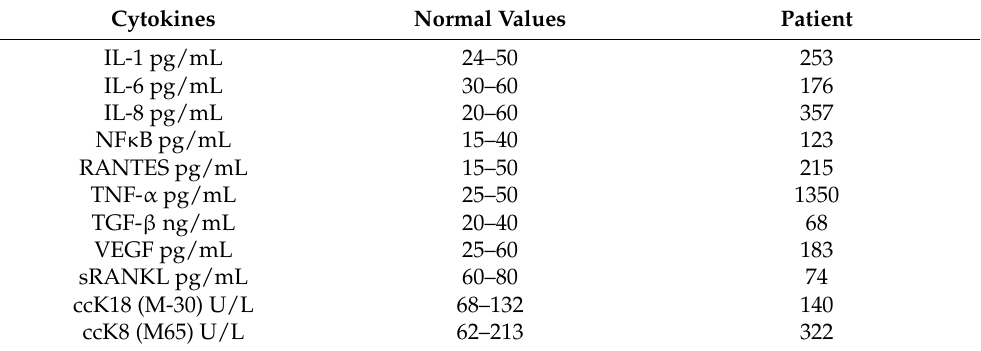
Table 1. Serum cytokine levels. Cytokines Normal Values